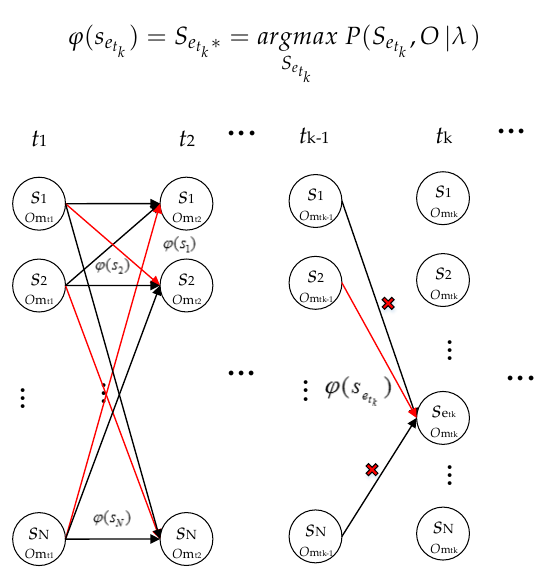
Figure 10. The graph of the Recursive Viterbi algorithm.